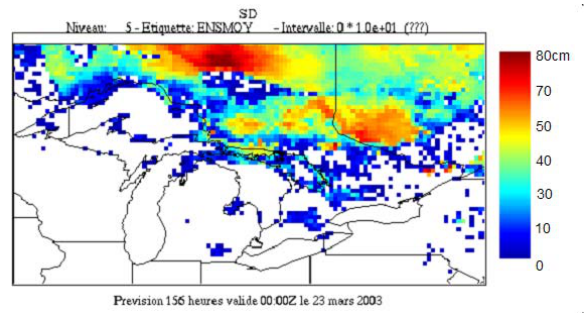
Fig. 17. Ensemble mean of snow depth, forecast issued on 16 March, valid on 23 March